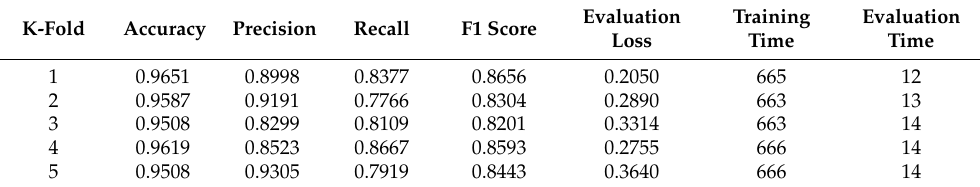
Table 12. BERT—Amazon Alexa Review